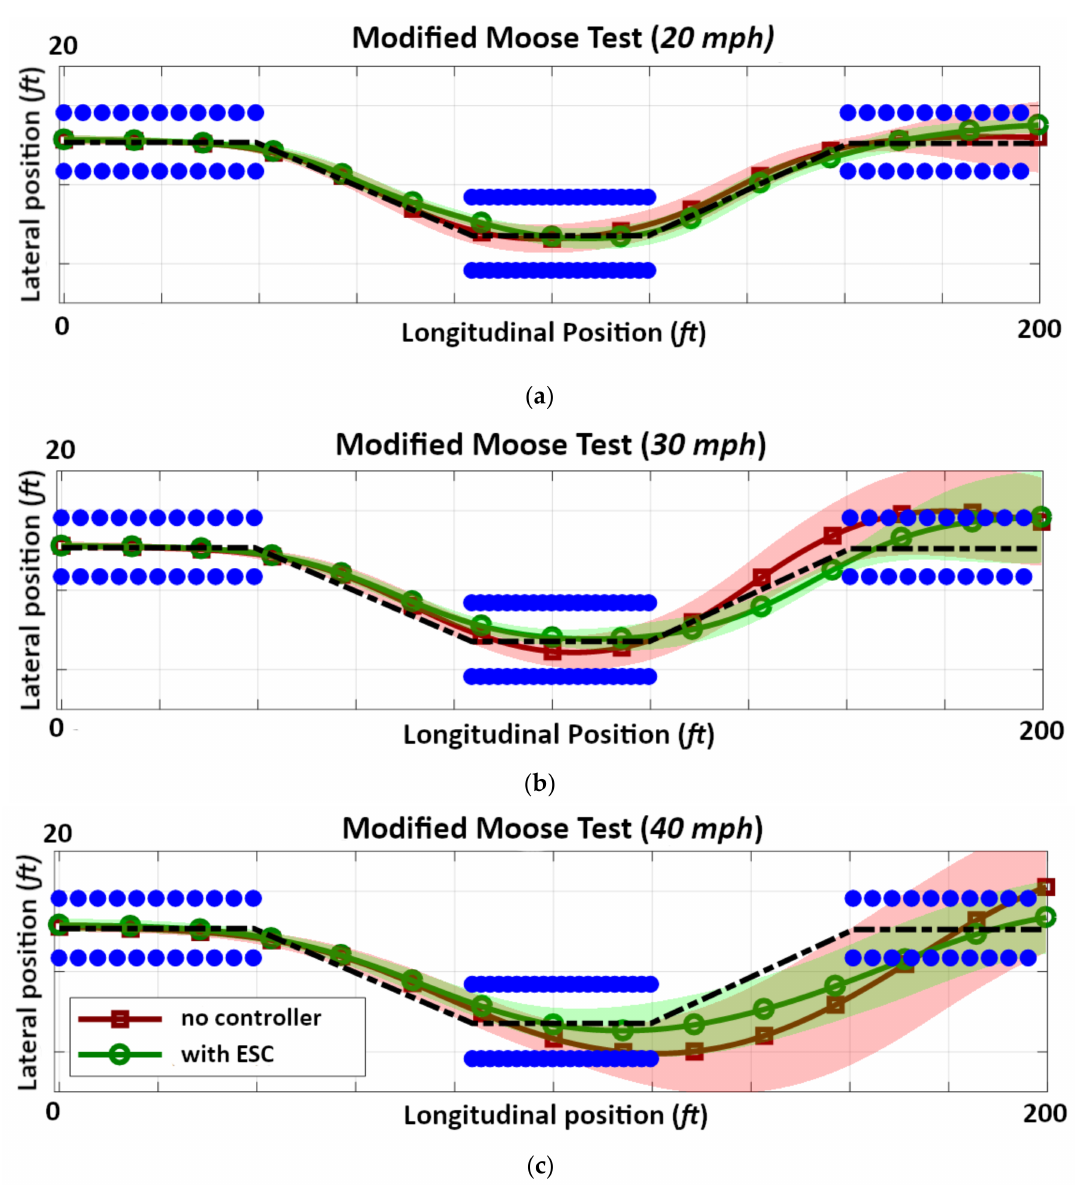
Figure 23. Modified Moose Test per cohort average trajectories at different entry speeds: ( a ) 20 mph, ( b ) 30 mph, and ( c ) 40